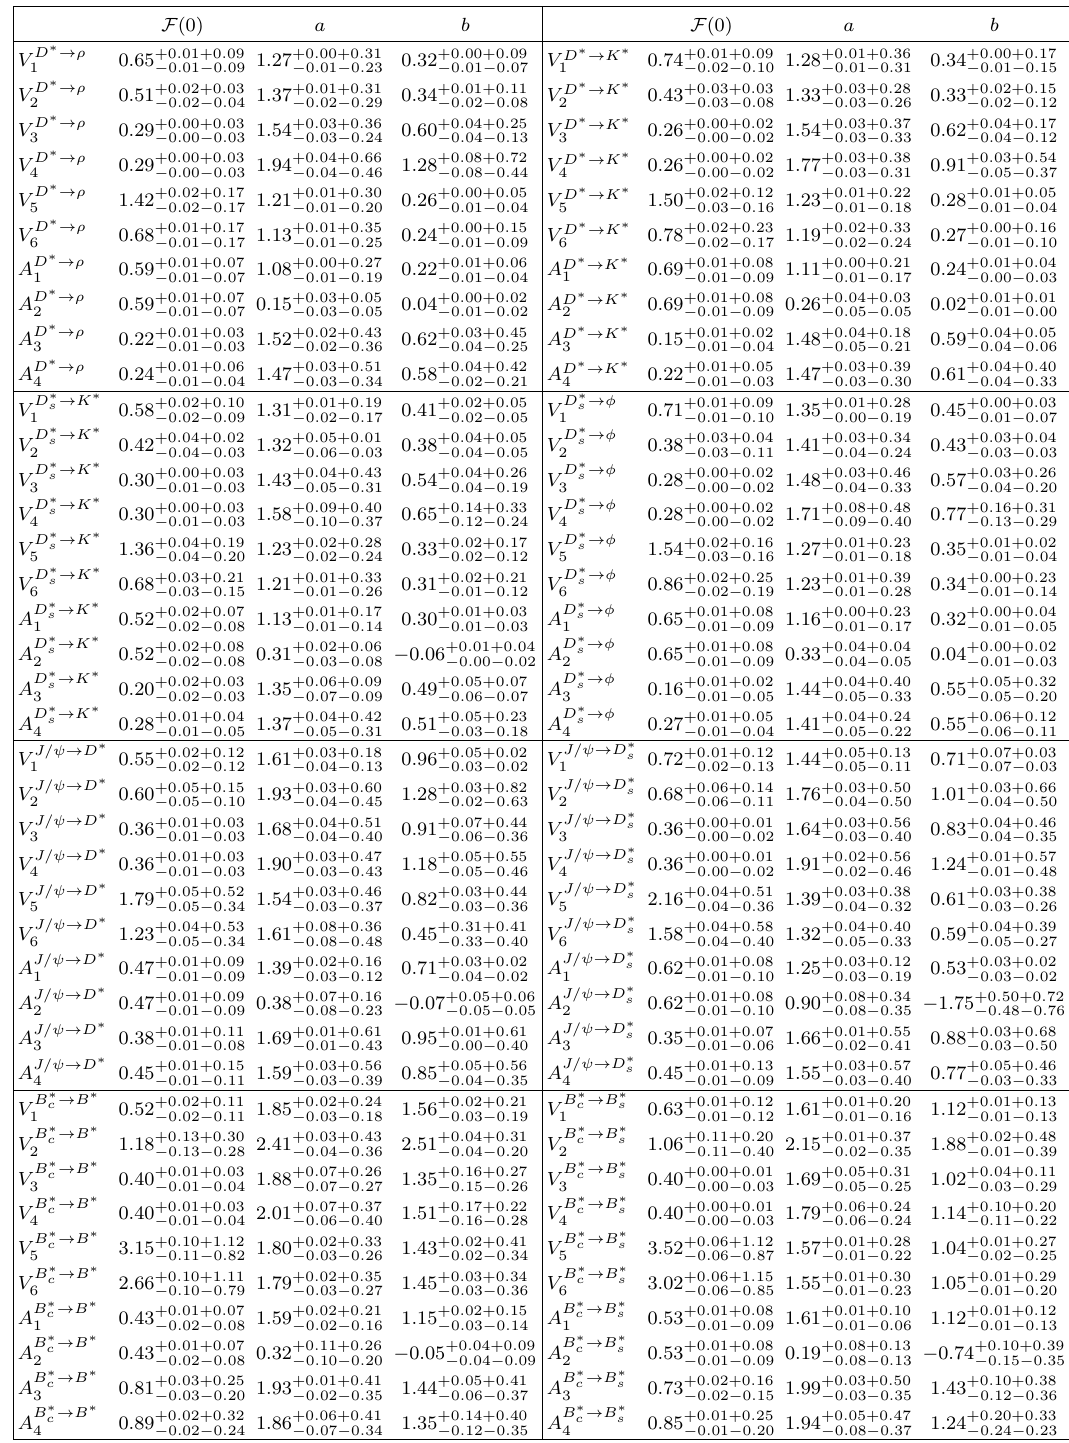
Table 8 . Same as table 4 except with the parameterization scheme given by eq. (4.15). The errors are due to parameters (cid:12) and quark masses only (cf. section 4 for a more complete discussion).